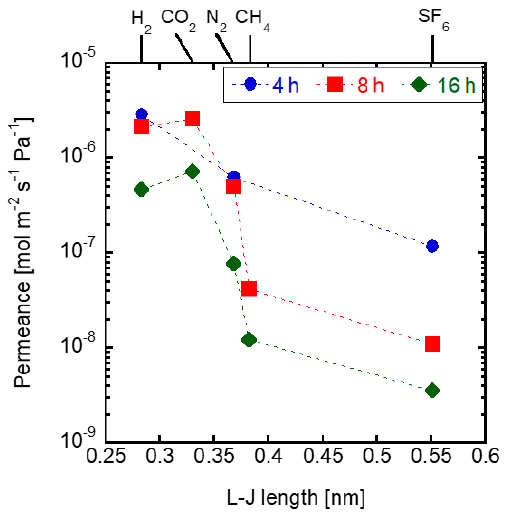
Figure 2. Single gas permeances through the membranes crystallized for varying synthesis times. (1 SiO 2 :0.8 TMAdaOH:0.8 HF:4.6 H 2 O, 0.01 wt% CHA seeds, at 423 K).